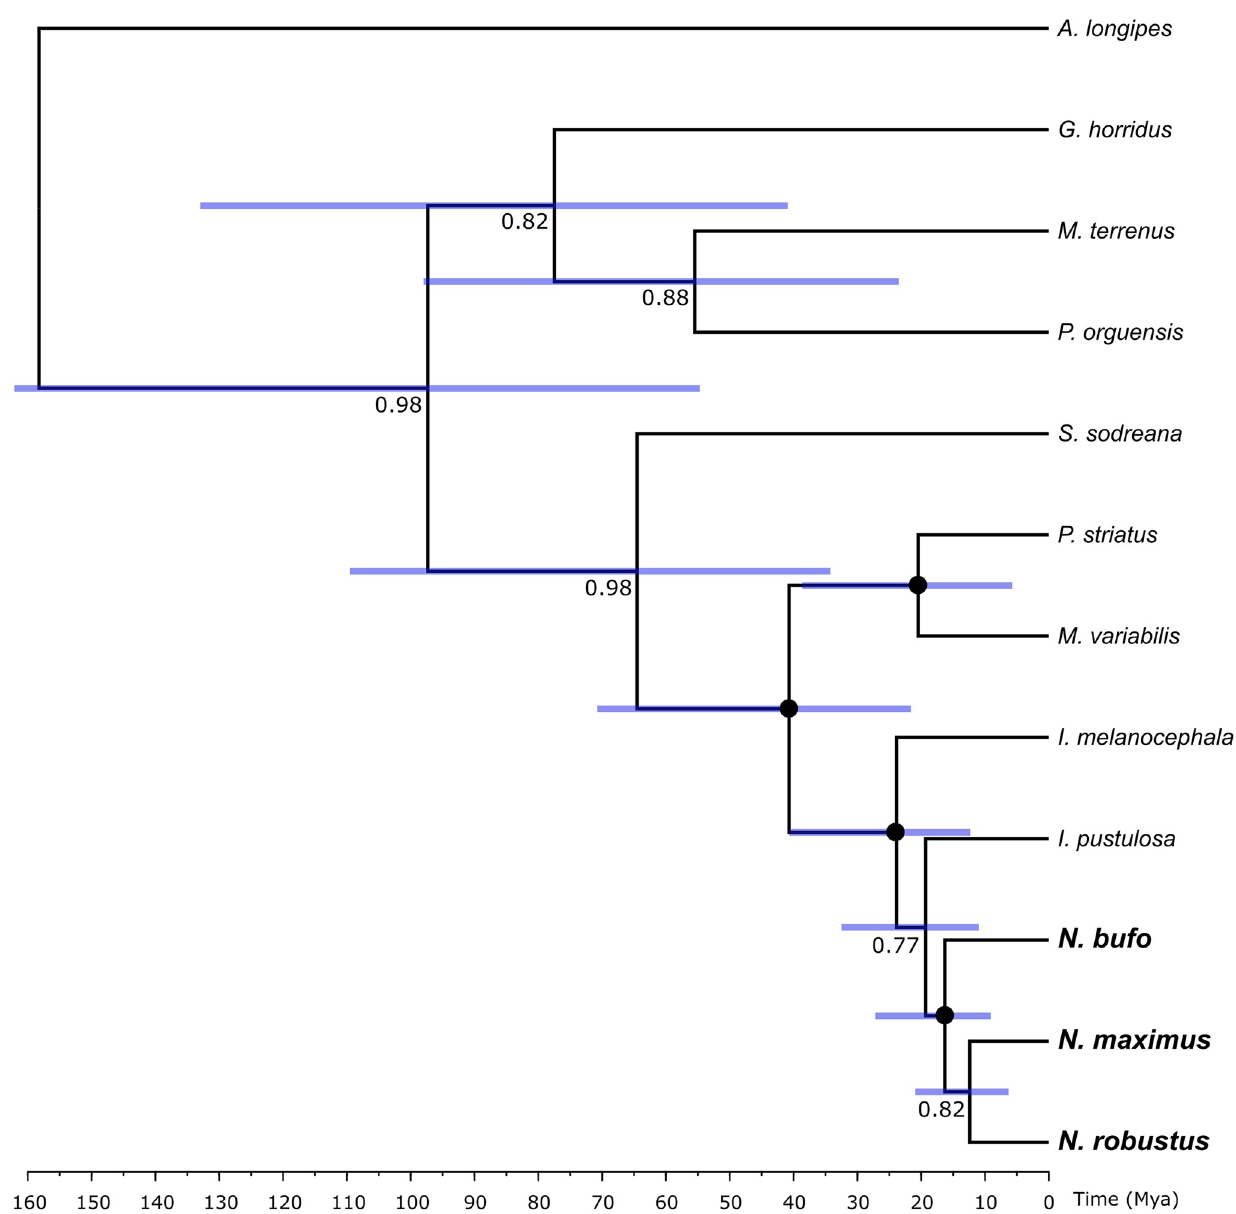
Fig 13. Multilocus calibrated tree obtained with � BEAST. The time scale is represented in millions of years. In the nodes, the posterior probability values; black circles represent posterior probability = 1. Blue bars show the 95% highest posterior density (HPD) intervals.